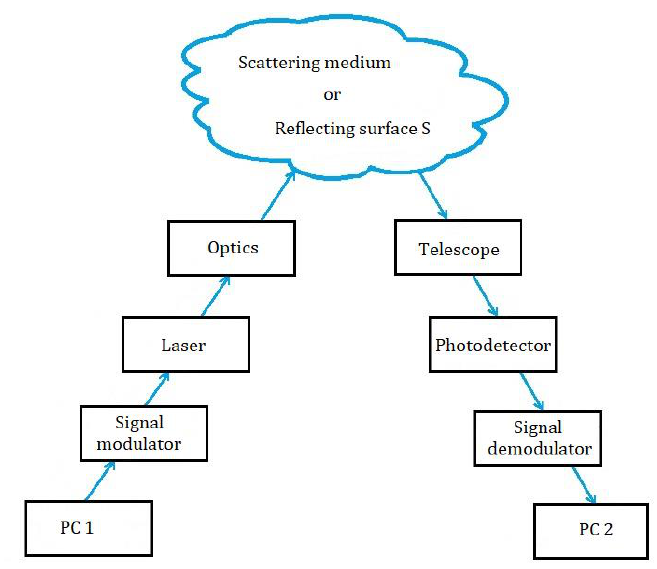
Figure 1. General block diagram of the non-line-of-sight (NLOS) communication system.